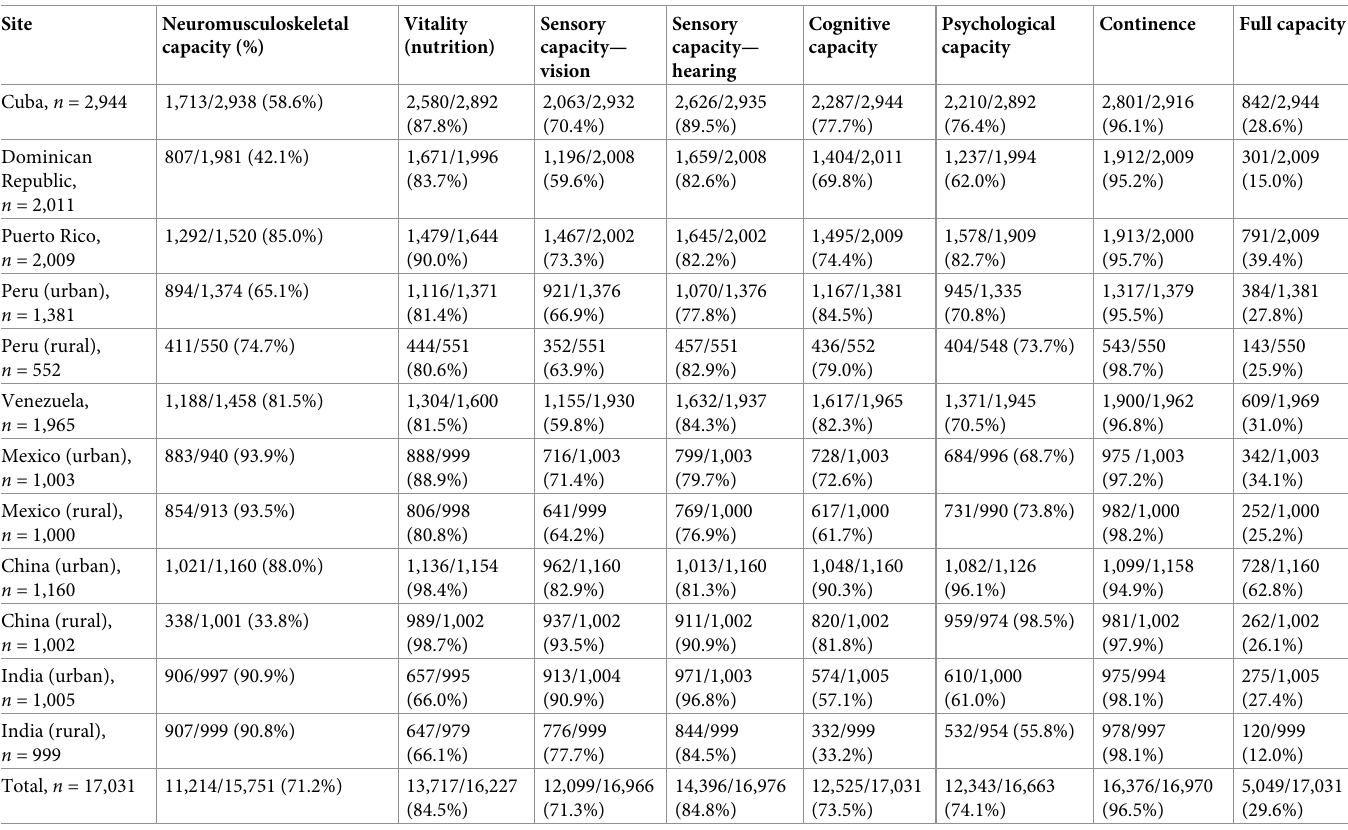
Table 2. Prevalence of individual capacities, and full capacity, by